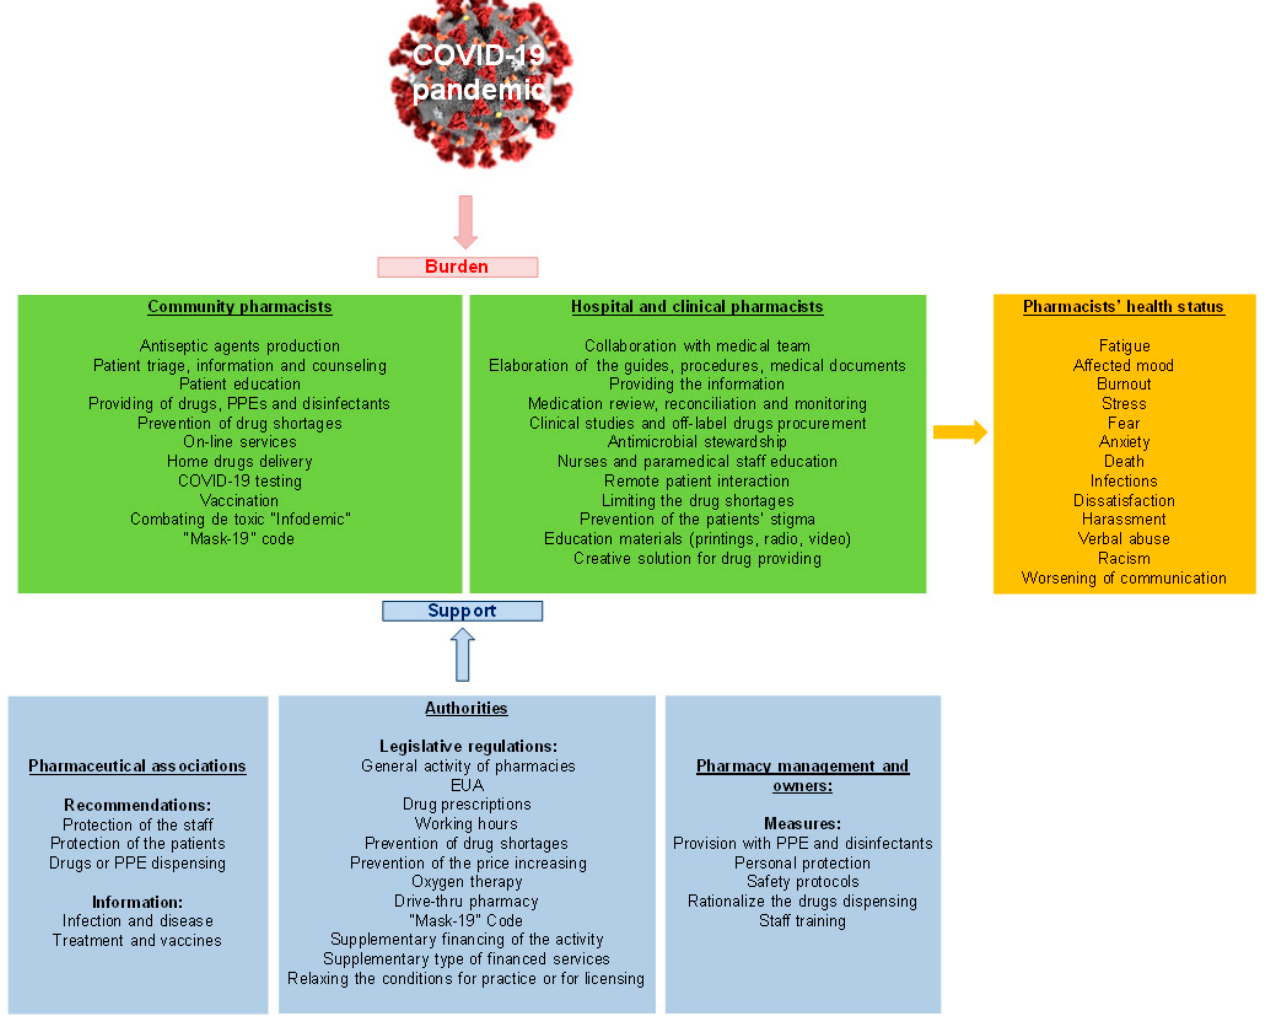
Figure 2. Pharmaceutical care: practice and influencing factors. PPE—personal protective equipment, EUA—emergency use authorization.